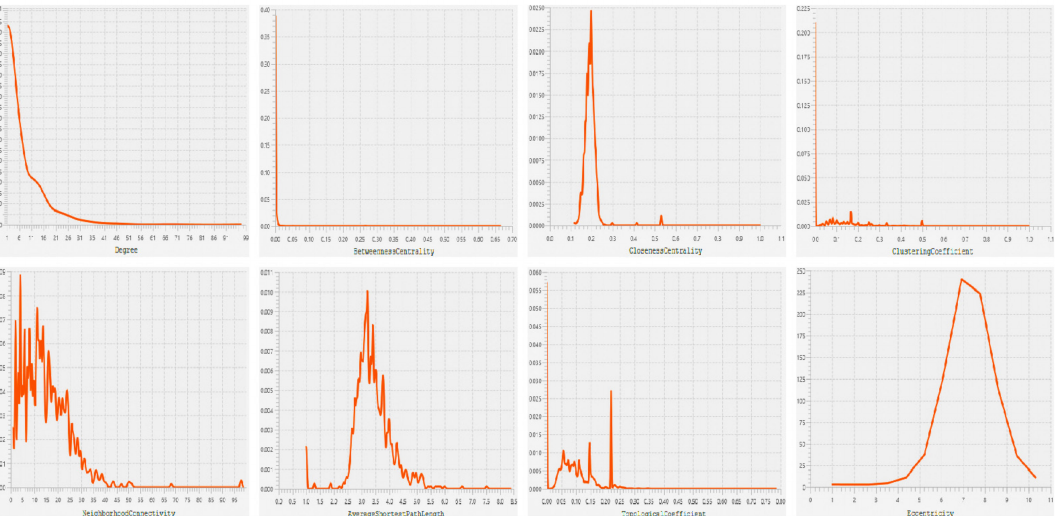
Figure 5. The topological property/centrality distribution plots showing the node degree distribution, the betweenness centrality, the closeness centrality, the clustering coefficient, the neighborhood con- nectivity, the average shortest path length distribution, the topological coefficient, and the eccentricity of PPI network. PPI network, protein–protein interaction